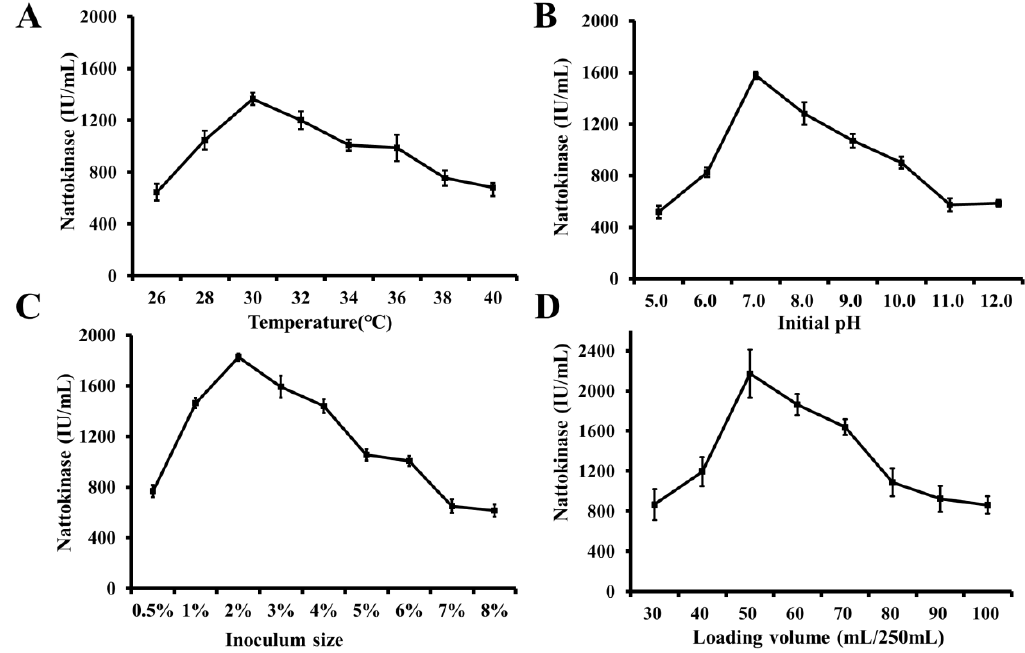
Figure 6. Optimization of fermentation condition for producing nattokinase of WTC016. ( A – D ) Effects of temperature ( A ), initial pH initial ( B ), inoculum size ( C ), and loading volume ( D ), on the NK activity of WTC016.